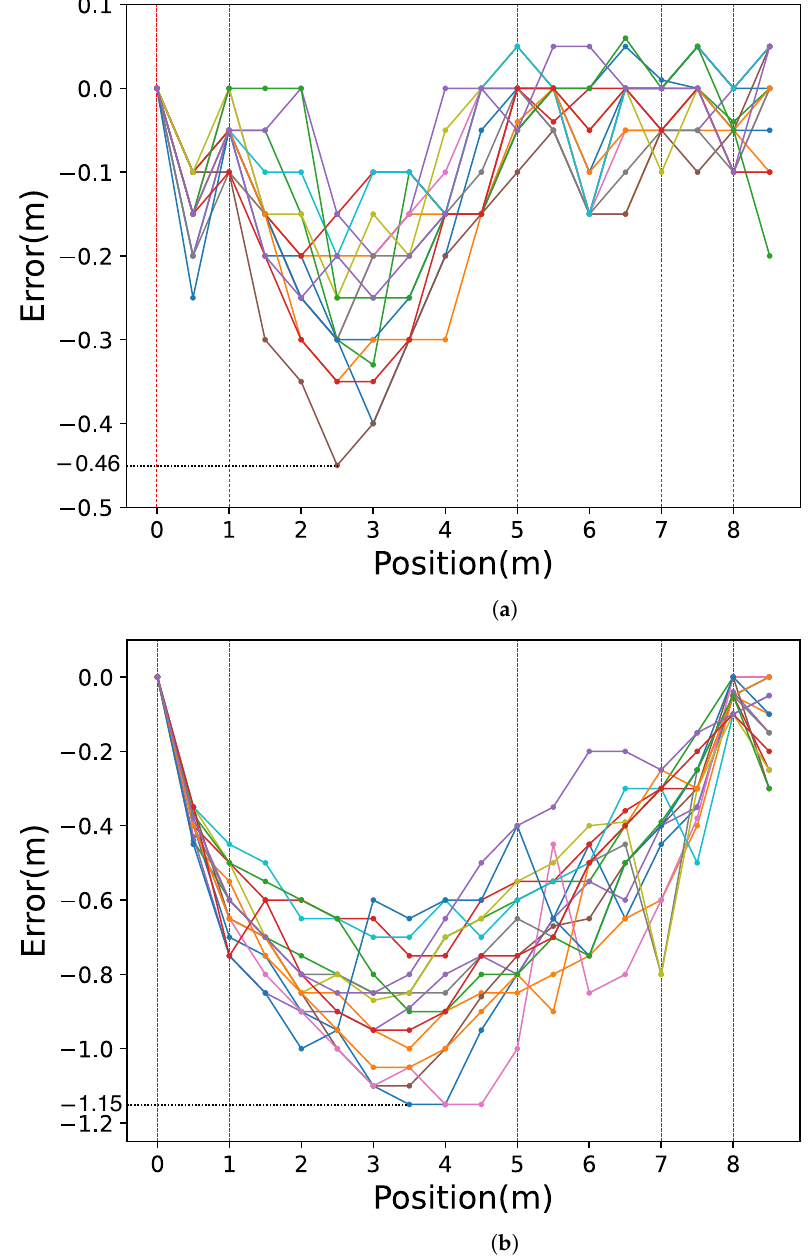
Figure 13. Video frame estimated position error. The error between estimated location and ground truth is depicted with different colors for each of the 15 trials. ( a ) Landmarks at 0 m, 1 m, 5 m, 7 m, and 8 m are used; ( b ) Landmarks at 0 m and 8 m are